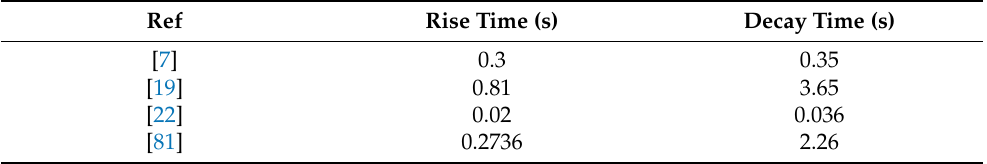
Table 5. Summary of rising time and decay time of hybrid graphene–perovskite NC photodetectors.